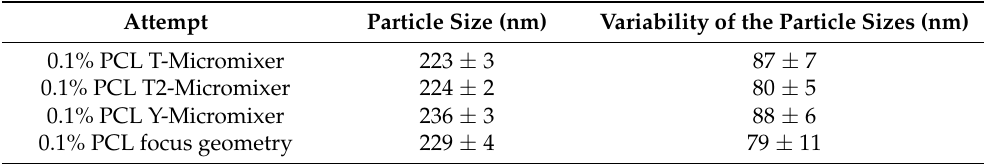
Table 7. Particle sizes obtained using different